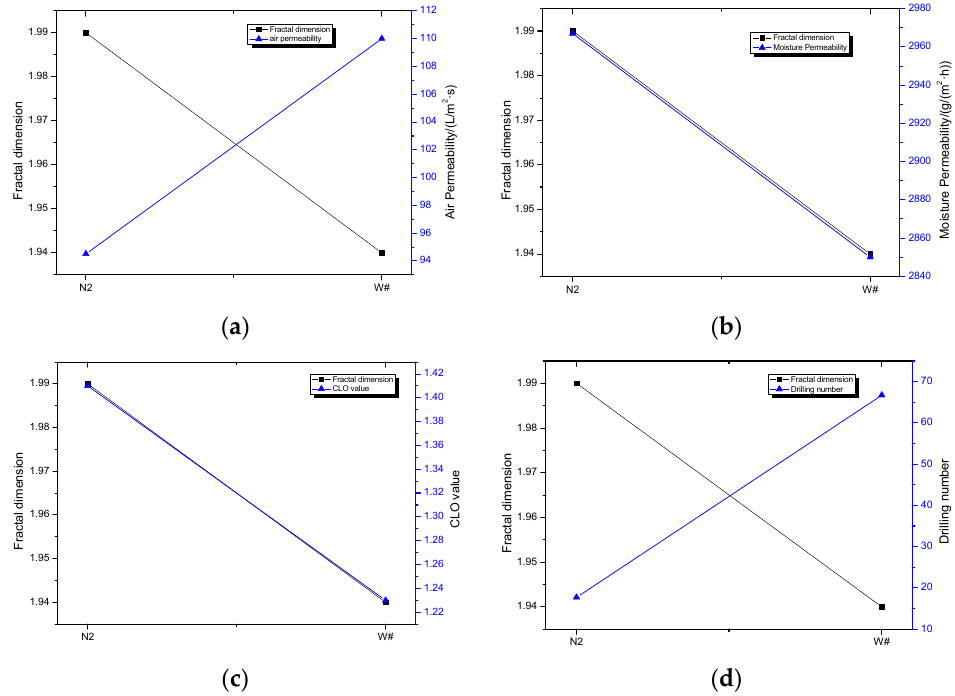
Figure 8. Relationship between pore fractal dimensions and ( a ) air permeability, ( b ) moisture permeability, ( c ) CLO value, and ( d ) drilling number of waddings.